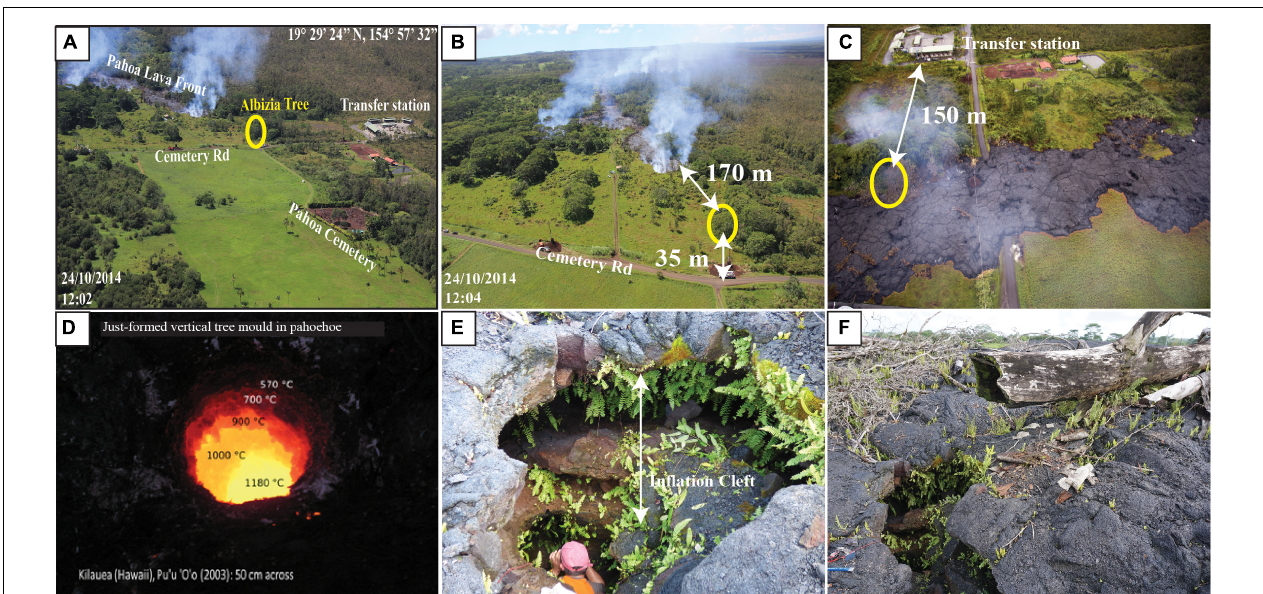
FIGURE 3 | (A,B) Helicopter-based photos of the lava flow front, transfer station, cemetery road and the studied tree location (yellow circle) taken on the 24 October by M. Patrick (USGS Hawaiian Volcano Observatory). (C) Helicopter-based photo of the “27th June” lava flow in the vicinity of Cemetery Road with the distance between the transfer station and the studied tree mold (photo courtesy of M. Patrick, USGS Hawaiian Volcano Observatory). (D) Recently created tree mold in a cooling p¯ahoehoe lava flow from Pu’u ‘Ô’ô (2003) with color-based temperatures (cf. Appendix of Harris, 2013). (E) View into the tree mold examined here in its inflation cleft (for scale, width of mold at base is 0.9 m). (F) View of the burned and felled tree portion (for scale trunk is 0.6 m in